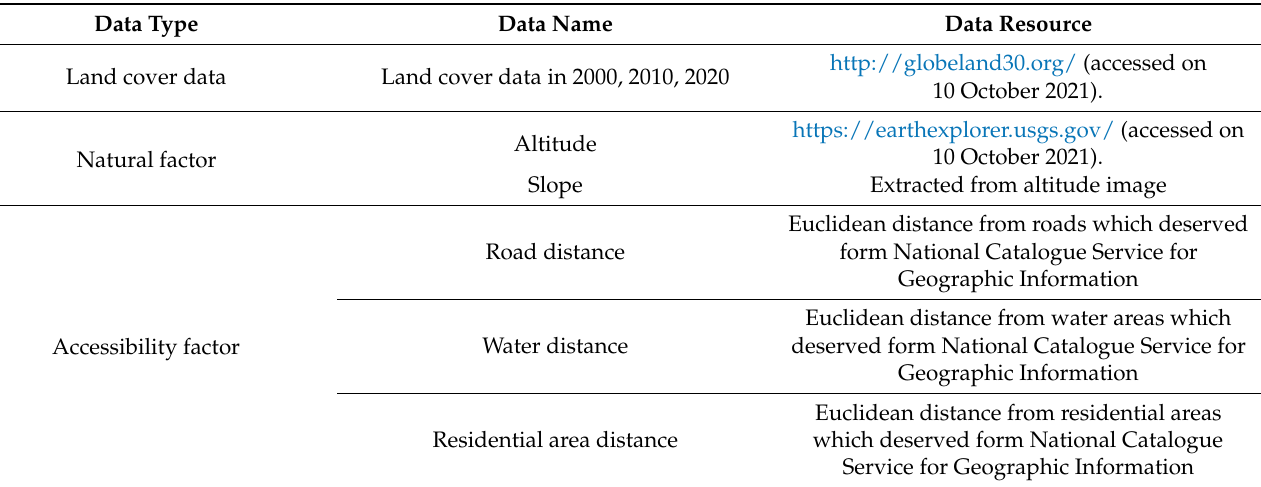
Table 1. The resource of land use data and driving factor data.